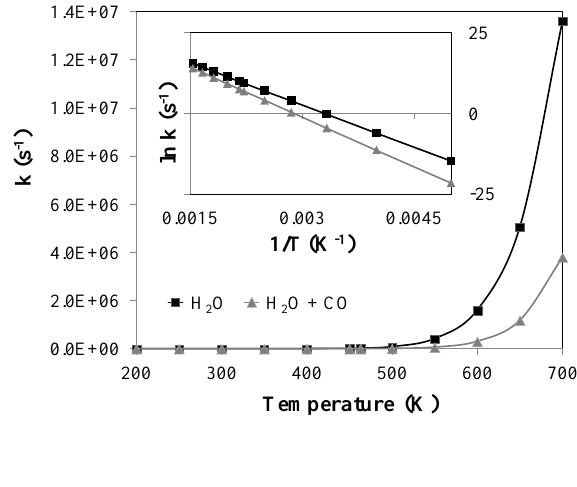
Figure 5. Temperature dependence of the reaction rate constant for the water dissociation reaction with and without co-adsorbed carbon monoxide. The Arrhenius format of the data is shown in the